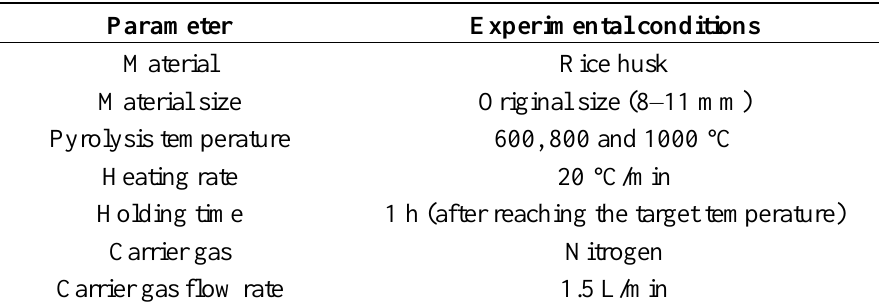
Table 2. Experimental conditions for char